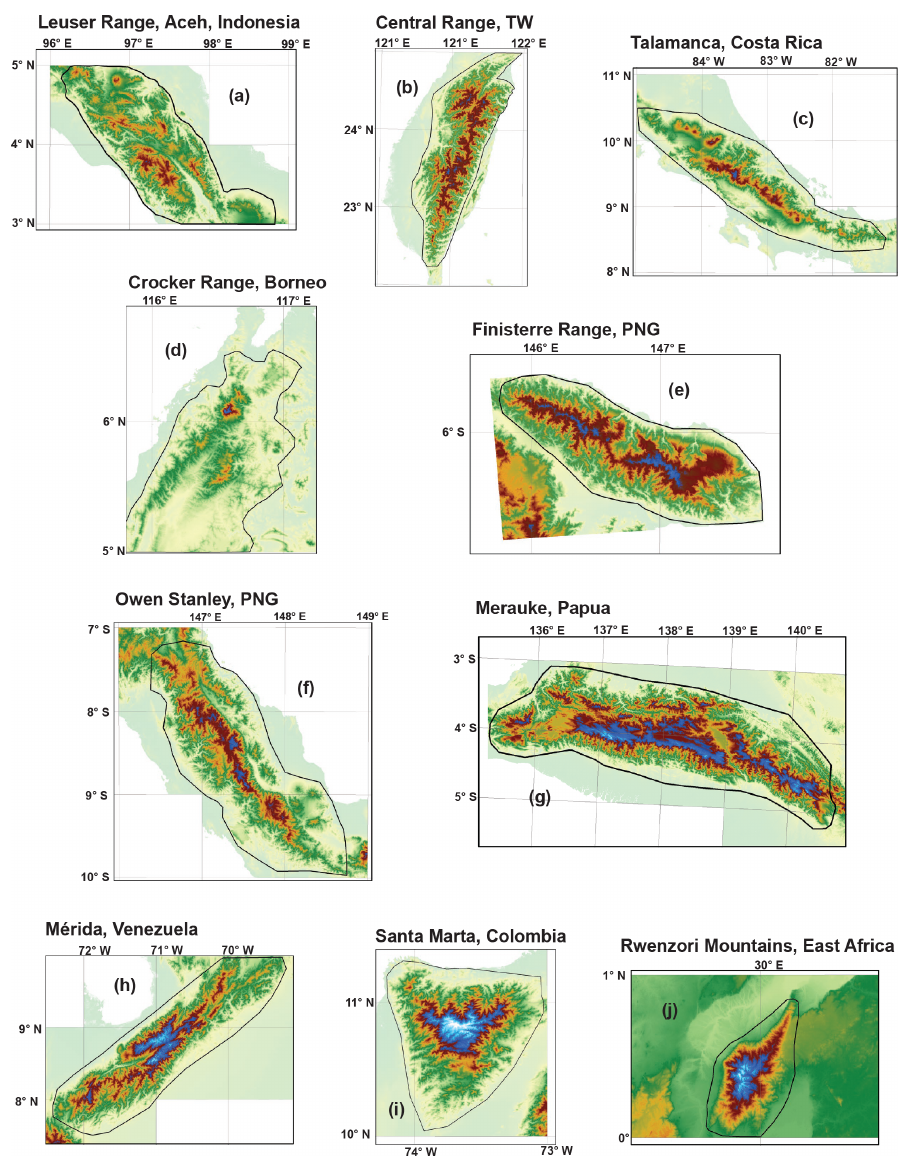
Figure 3. (a–j) SRTM DEMs of selected tropical mountain belts. Yellow-green through red spans elevations 0–3400m. Dark blue to light blue is 3400–4500m (tropical cpELA to wpELA). Black polygons circumscribing each range indicate bounds for hypsometric analysis in Fig.